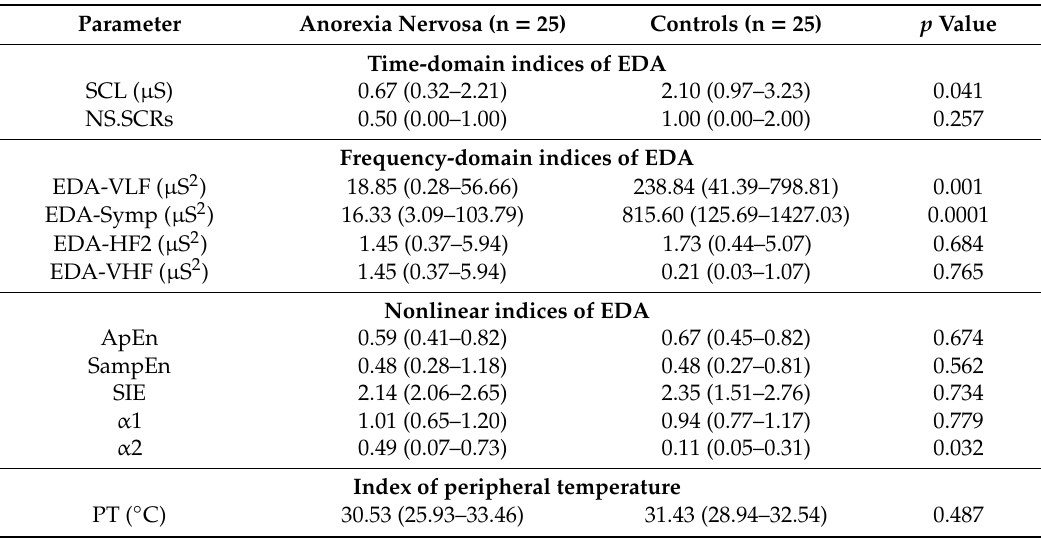
Table 2. Parameters of electrodermal activity and peripheral